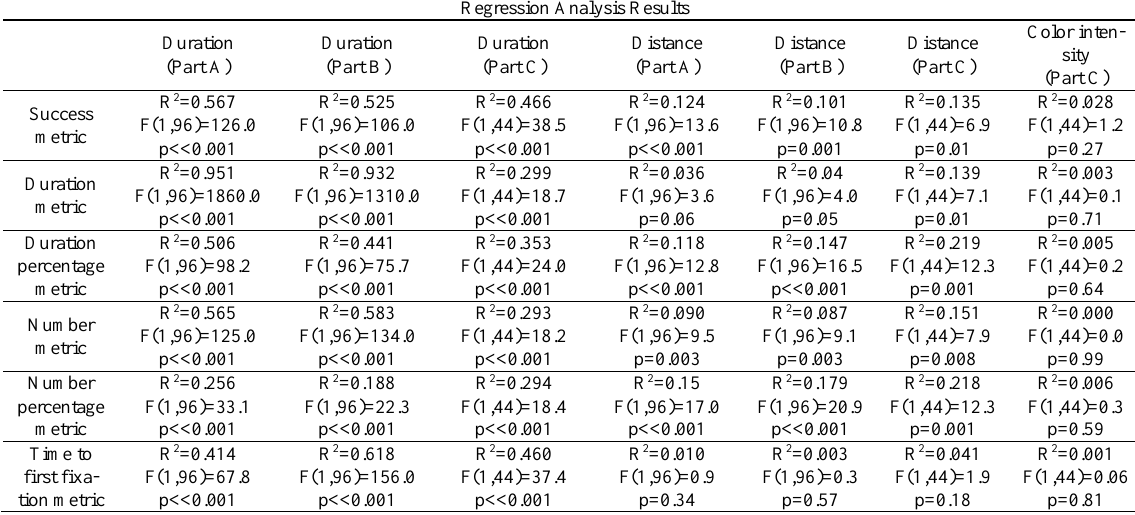
Regression analysis results (R 2 , F, p values). Experimental parameters and statistical metrics serve as the dependent and the independent variables correspondingly for the performance of the regression analysis. Regression Analysis Results